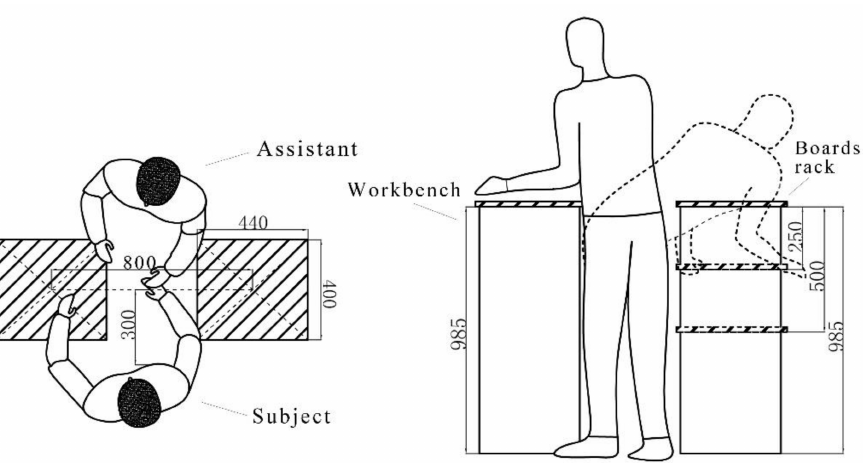
Figure 3. Illustration of the handling experiment layout and the test variable design: the subject and the assistant stand face to face with a distance of 600 mm, between them the workbench and the boards rack placed in a line. While the workbench is set at a fixed height, the sheets rack is set at three height levels. The subject moves the board from the rack to the workbench, while the assistant transports it in the opposite direction.